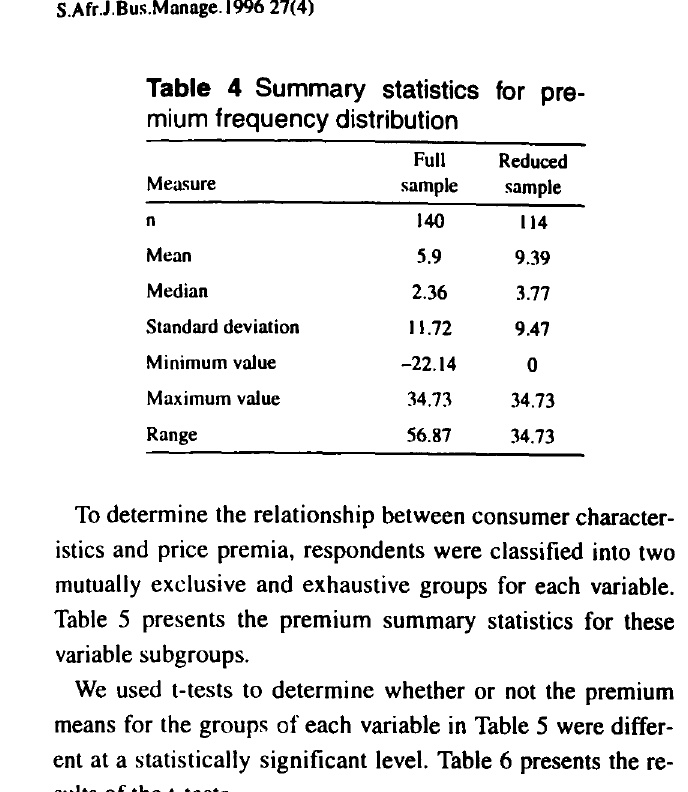
Table 4 Summary statistics for pre